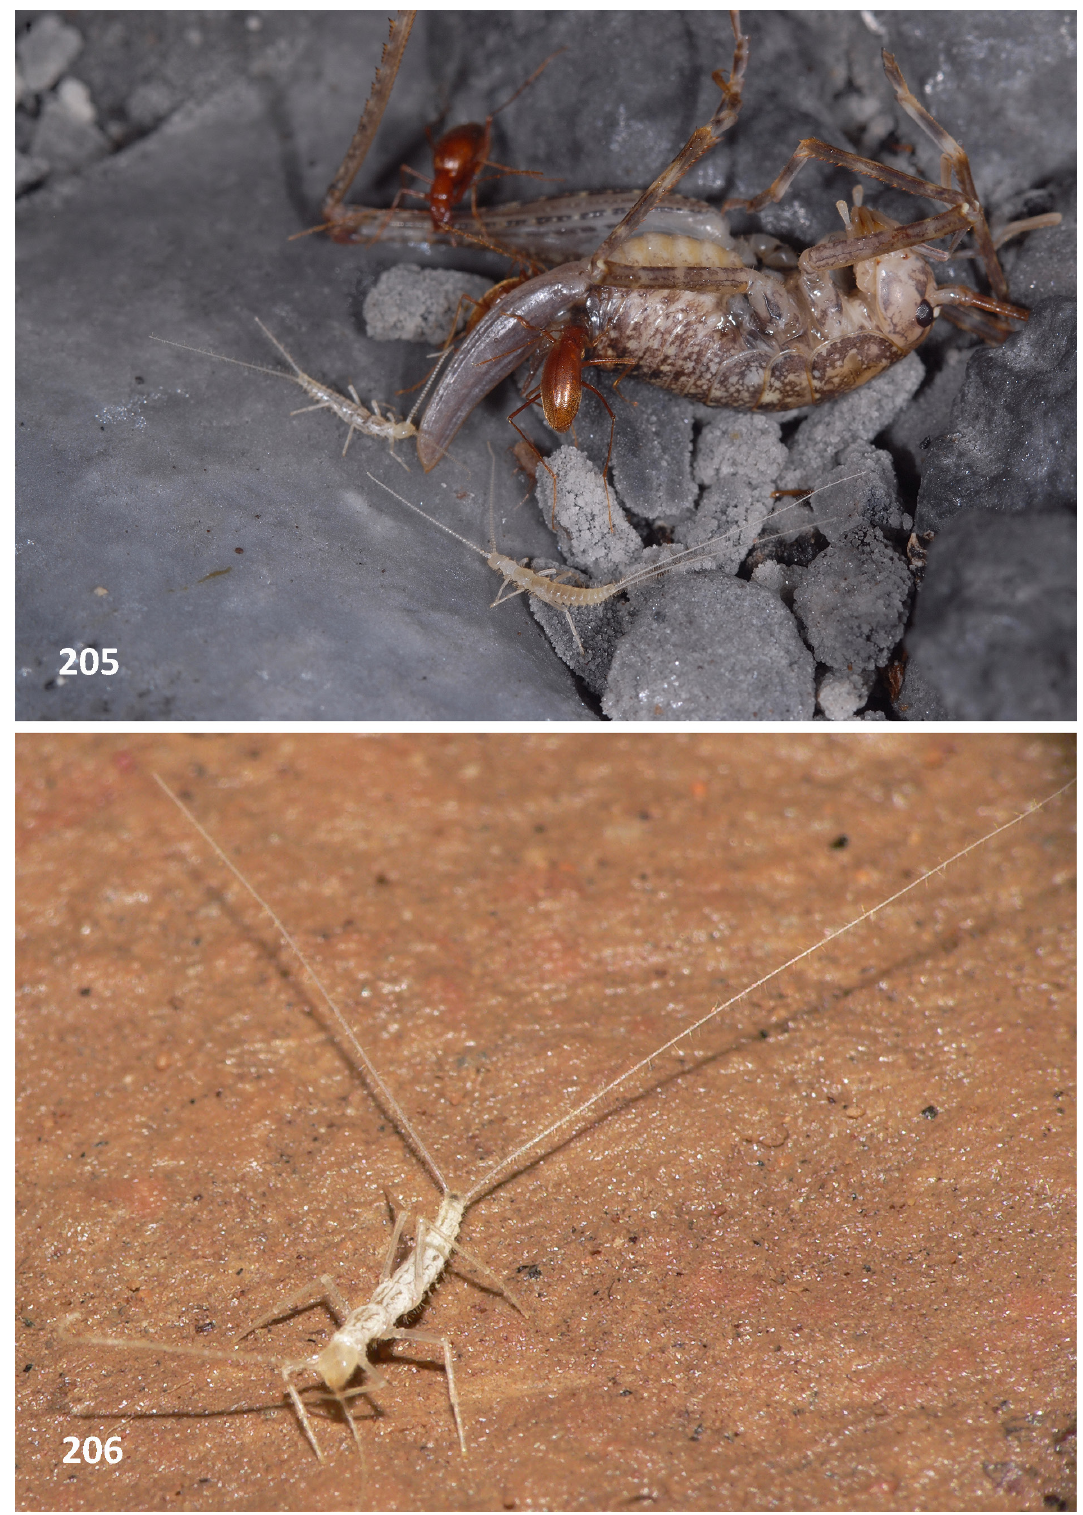
Figs 205–206. 205 . Plusiocampa ( Stygiocampa ) dalmatica Condé, 1959 and the beetle Parapropus vitorogensis Ćurčić et al. , 2012 (Leptodirini) feeding on a dead cave cricket, Troglophilus sp., in Vaganska pećina, Bosnia and Herzegovina (photo: Slavko Polak). 206 . Paratachycampa hispanica Bareth & Condé, 1981, from Cirat Cave, Castellón, Spain (photo: Sergio